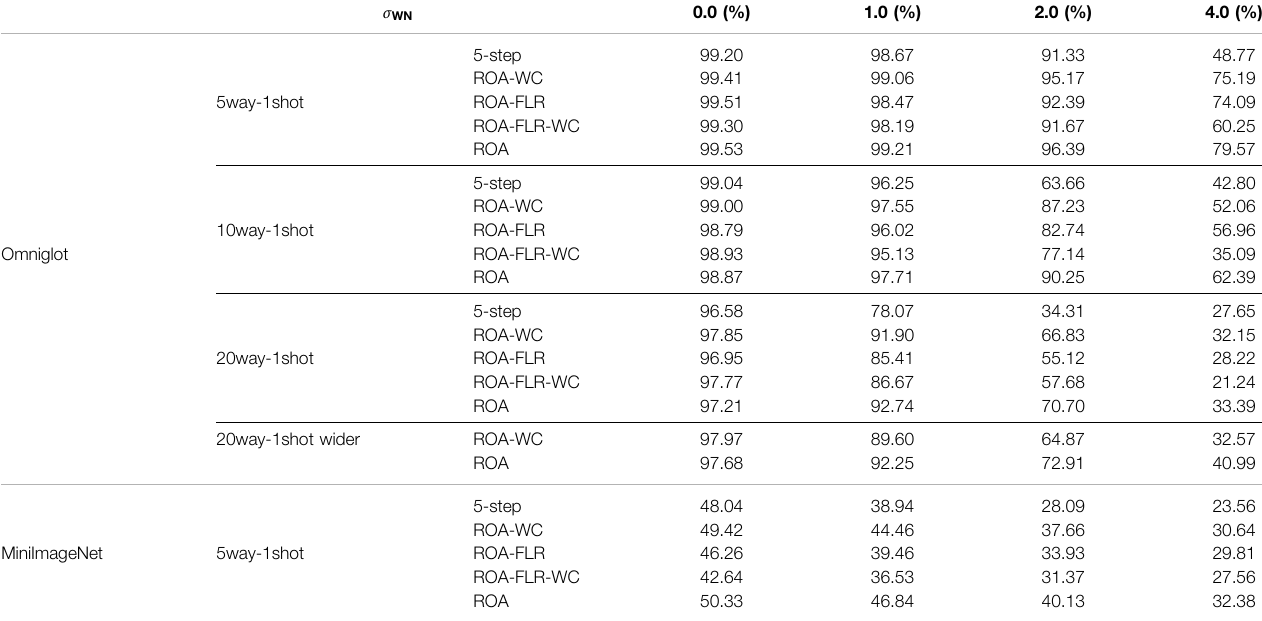
TABLE 2 | Comparison of the accuracy of ROA, 5-step update, ROA without constraint (ROA-WC) and fi xed learning rate (ROA-FLR) in different write